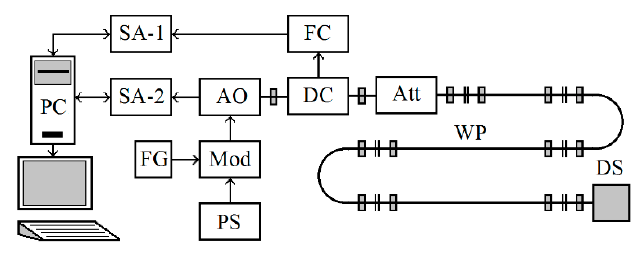
Figure 10. Block diagram of the experimental setup.